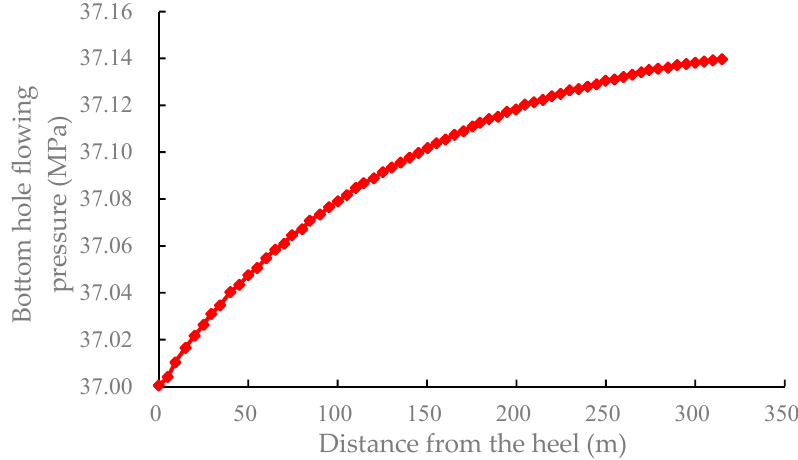
Figure 8. Distribution of bottom hole flowing pressure along the horizontal lateral.